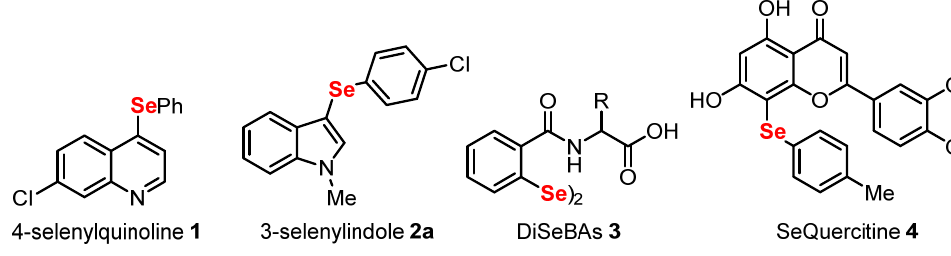
Figure 1. Bioactive organoselenium compounds.